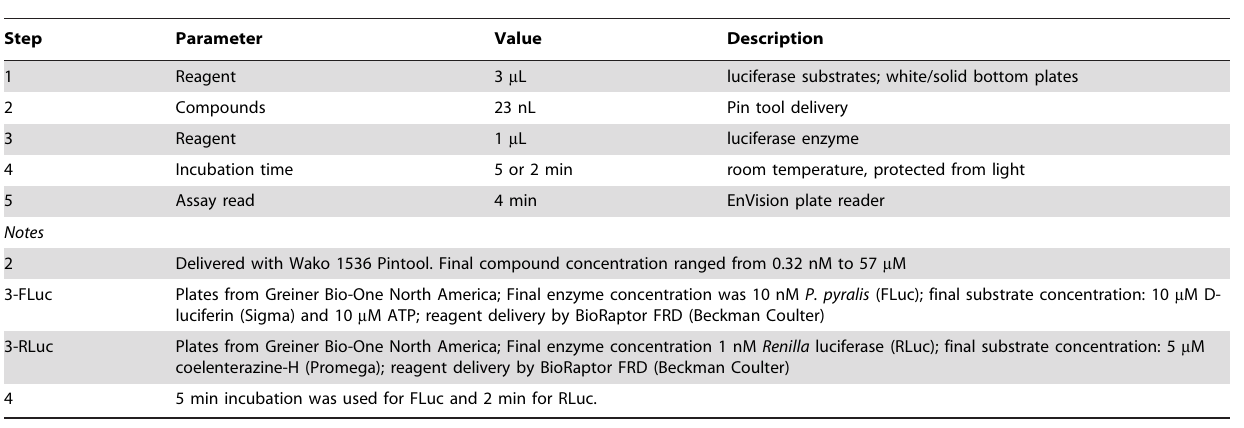
Table 1. FLuc or RLuc assay (1536-well plate format).